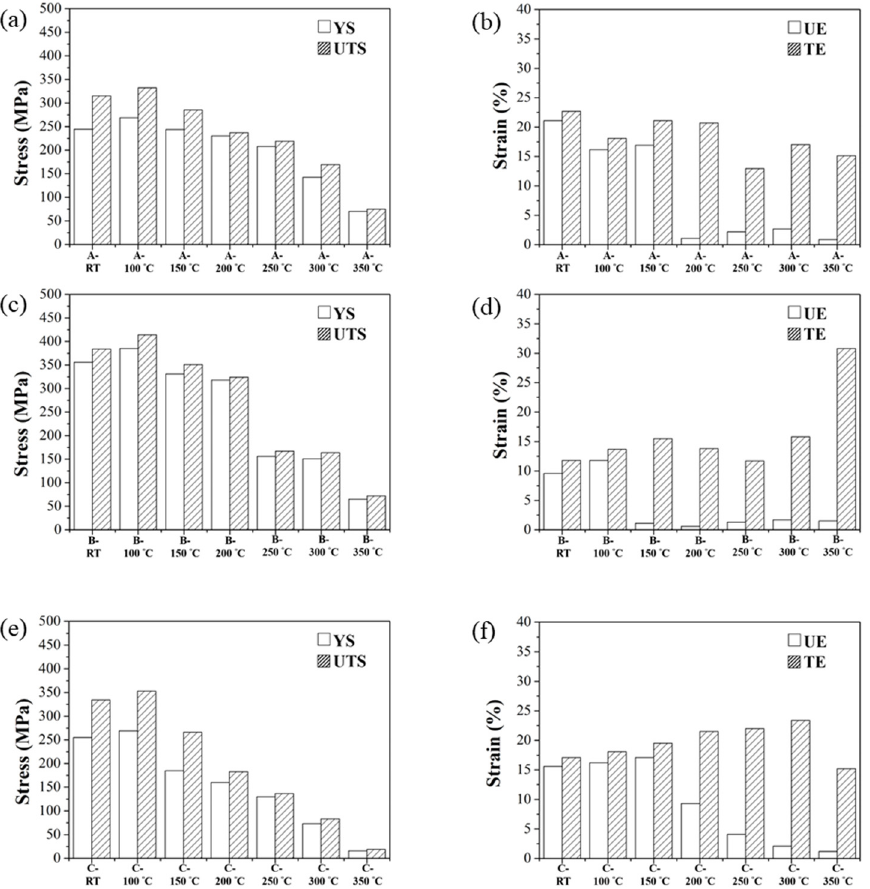
Figure 7. Hightemperature tensile properties of as-printed specimens’ ( a ) strength and ( b ) ductility, single-stage-heat-treated specimens’ ( c ) strength and ( d ) ductility, and two-stage-heat-treated specimens’ ( e ) strength and ( f ) ductility.